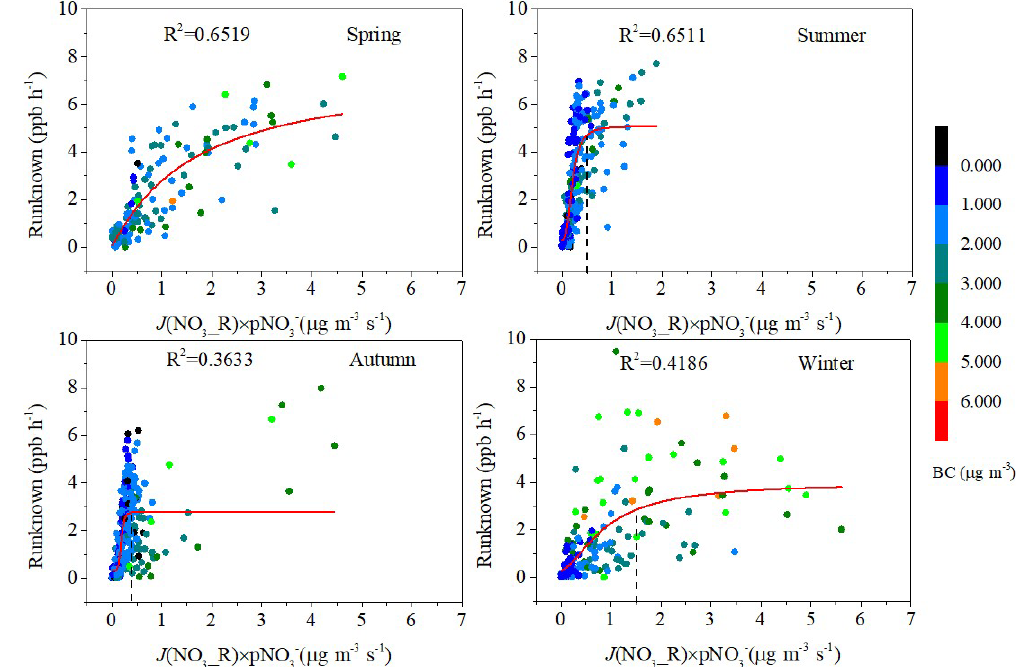
Figure 9. Relationships between the photolysis of particulate nitrate and R unknown , colored by BC in spring, summer, autumn, and winter. Red lines and dashed lines represent logarithmic fitting curve and turning point, respectively.